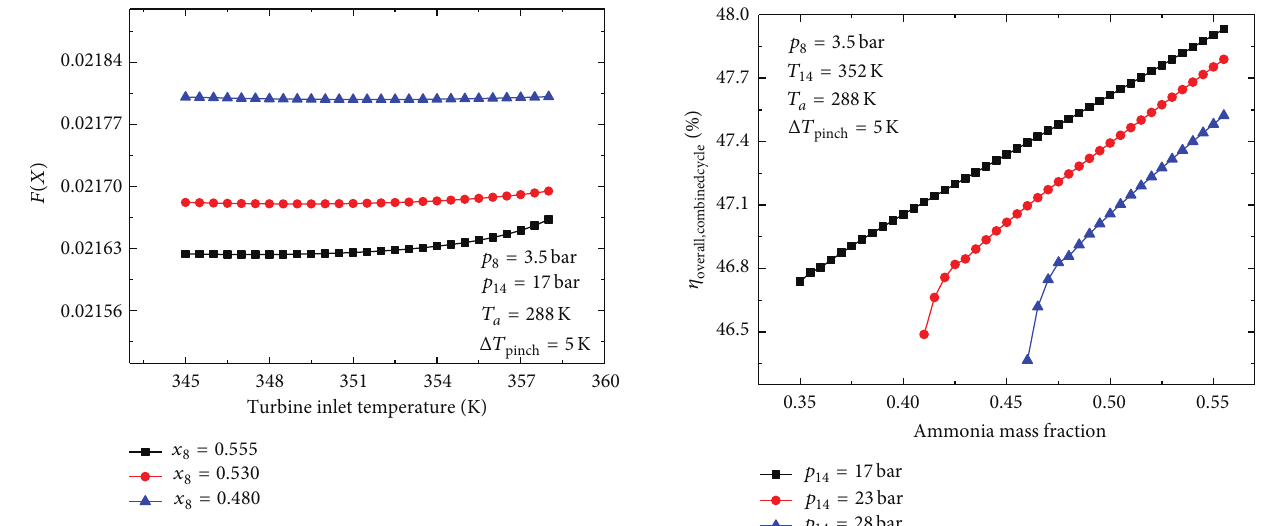
Figure 13: Variation of 𝐹(𝑋) of combined cycle with turbine inlet temperature.